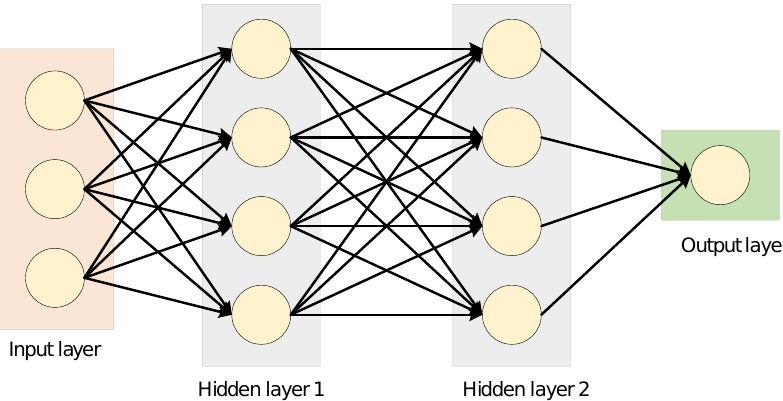
Figure 4. A simplified view of a feedforward artificial neural network [77].